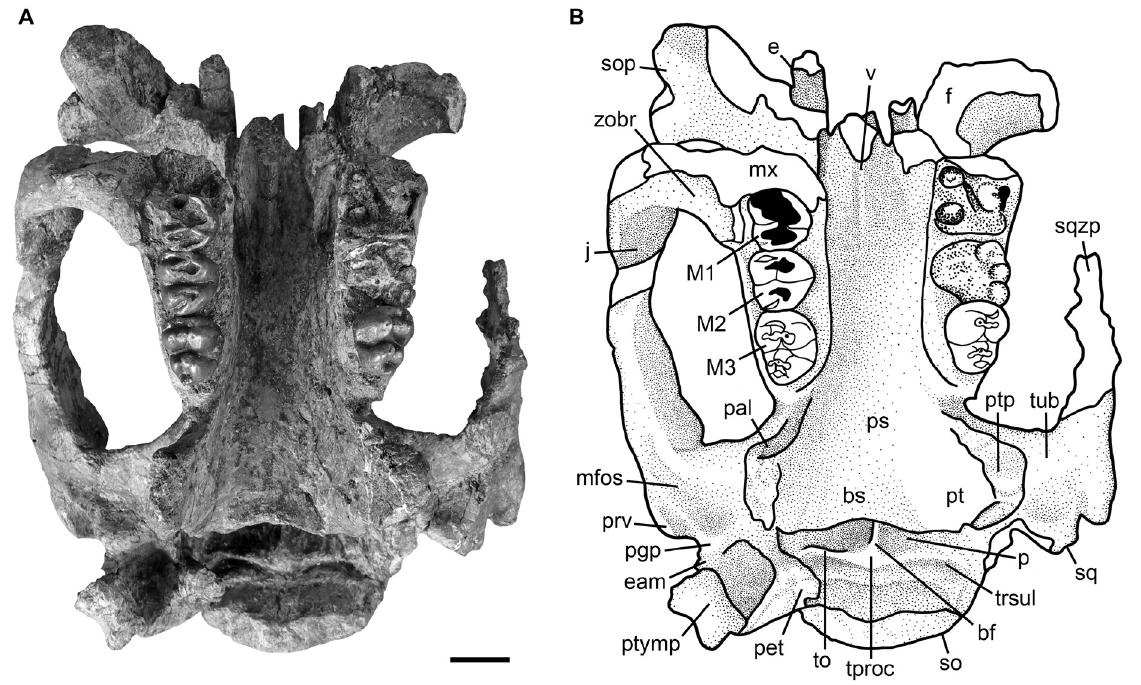
Fig. 3. Cranium of Lentiarenium cristolii ( Fitzinger, 1842) (OLL 1926/394) in ventral view. A . Photograph. B . Drawing. White areas indicate either missing or reconstructed parts. Scale bar = 2